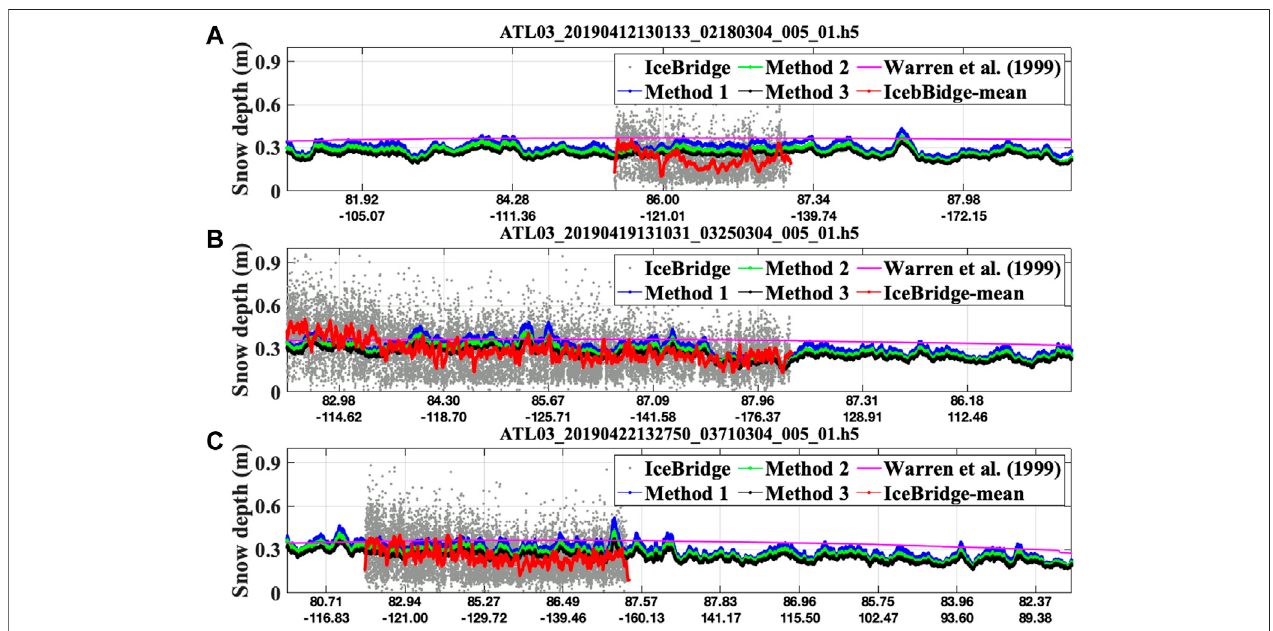
FIGURE 4 | Comparison of snow depth from three different sources: ICESat-2 snow depths by Eqs 1 – 3 (blue, green, and black) from central strong beam, IceBridge snow depth (gray points, red curve), and climatology snow depth (pink) by Warren et al. (1999). The ICESat-2 and IceBridge ground tracks on April 12 (A) , 19 (B), and 22 (C) , 2019 are shown as black lines in Figure 3 .